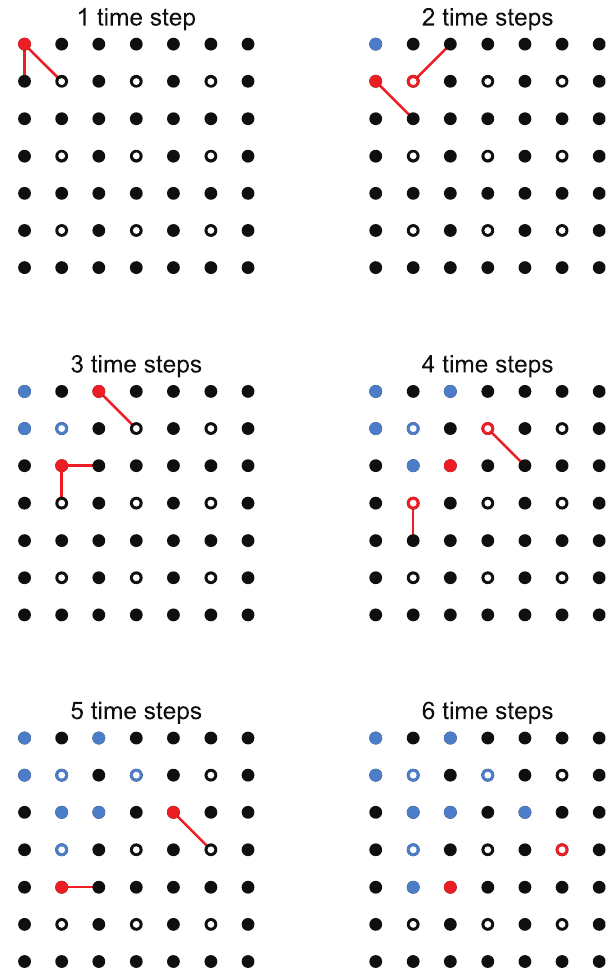
Figure 3. Avalanche propagation. Example of one avalanche propagating in an undersampled 7 | 7 network for 6 time steps. The 3 | 3 sampling matrix is denoted by empty circles. Red circles represent active sites, blue indicates sites that were activated during avalanche propagation. Red lines show spike propagation.